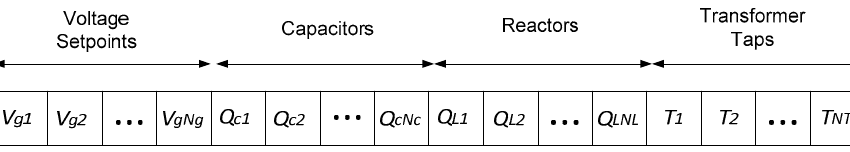
Figure 2. Codification of the implemented GA.